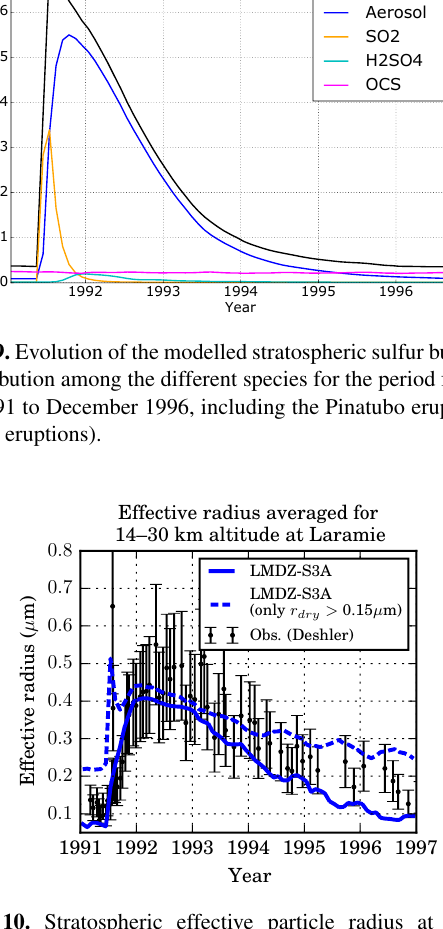
Figure 10. Stratospheric effective particle radius at Laramie, Wyoming (41 ◦ N, 105 ◦ W), as simulated by the LMDZ-S3A model and observed with optical particle counters (Deshler et al., 2003). Error bars of the measurements were determined from the 40% uncertainty in aerosol surface area A and volume V assuming a correlation coefficient of 0.5 between A at different altitudes, V at different altitudes, and A and V at the same altitude.